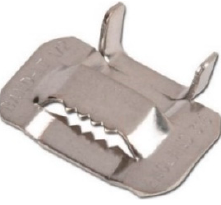
Figure 27. The seal used in the experimental program.